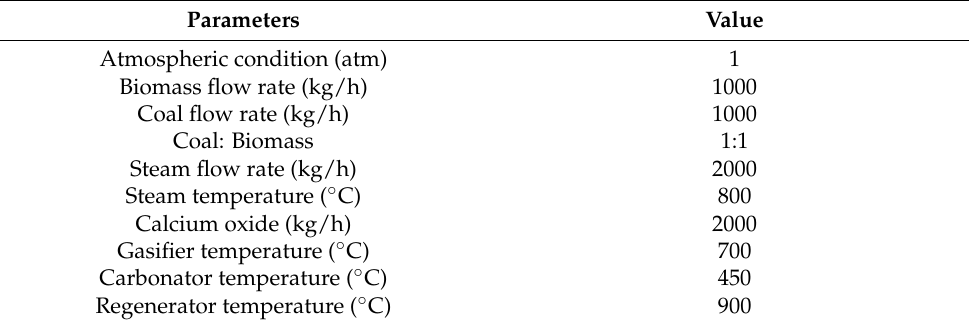
Table 2. Input parameters of each stream and unit operation used in the simulation